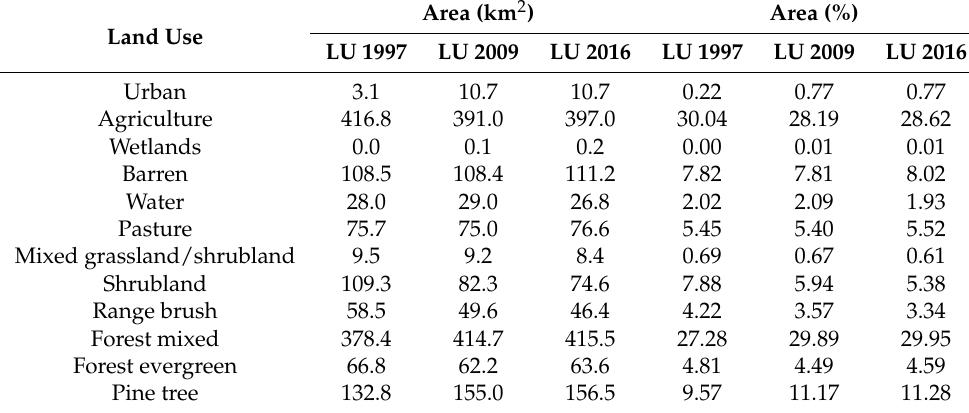
Table 3. Distribution of land uses for LU 1997, LU 2009, and LU 2016 by km 2 and relative values (%).